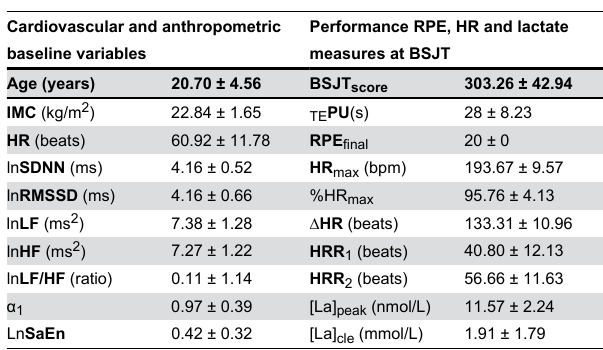
Abbreviations are explained in Table 1. doi: